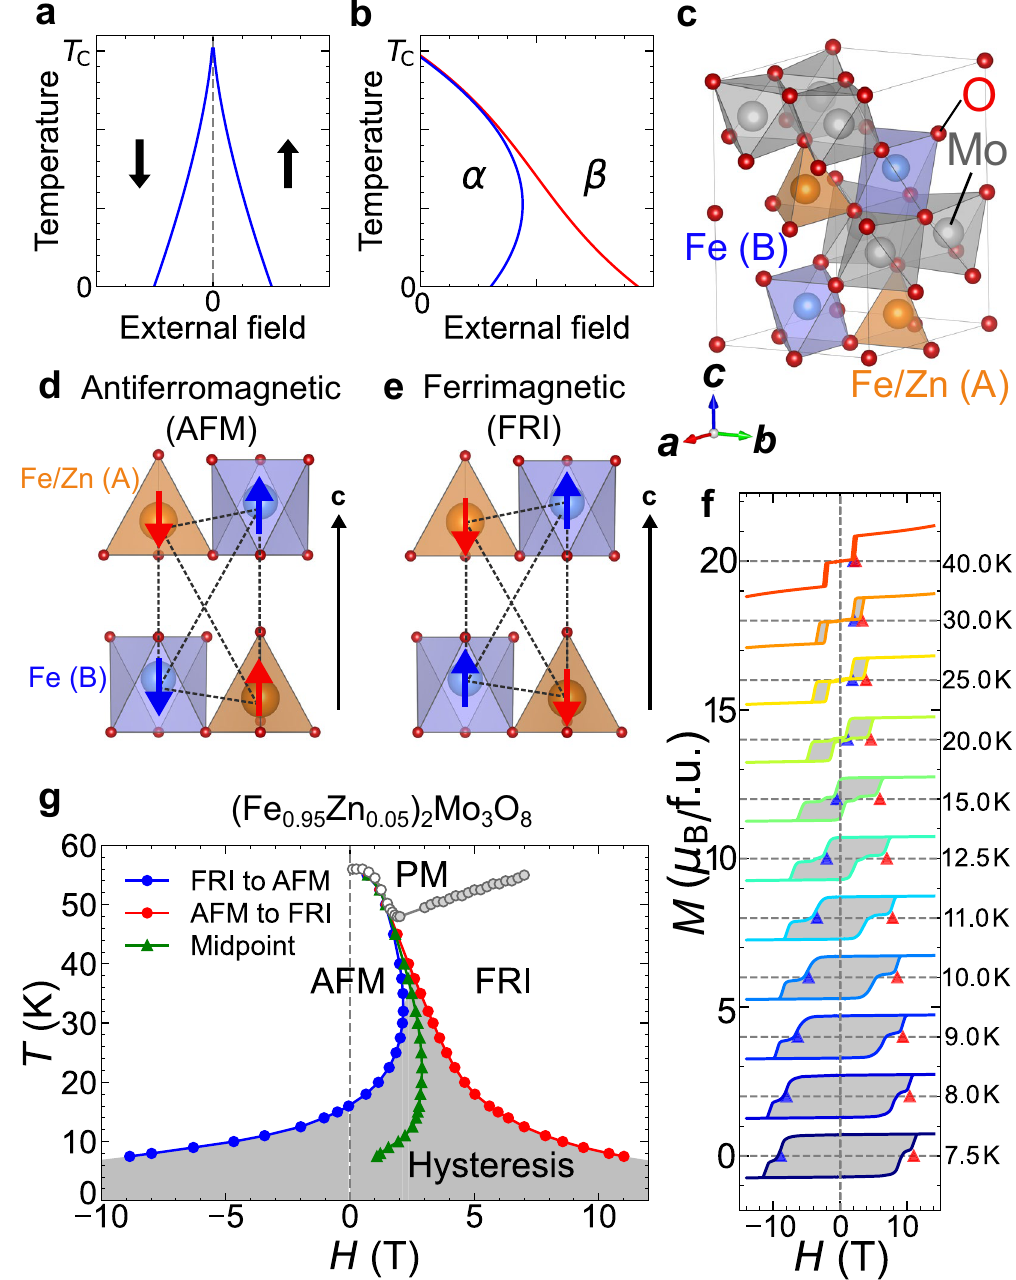
Figure 1. Field-temperature phase diagram of ( Fe 0.95 Zn 0.05 ) 2 Mo 3 O 8 . ( a,b ) Phase diagrams with temperature and external field axes in the system with field-induced first-order phase transitions: ( a ) ferroic-order case in which two states are connected with symmetry operations, such as time-reversal and space-inversion symmetries, and ( b ) two-phase-competing case in which two thermodynamic phases indicated by α and β are not degenerate in free energy at zero external field. The solid lines in ( a ) and ( b ) represent magnetic fields at which the phase transition is observed during magnetic field sweeps 2 + at a given rate. ( c ) The crystal structures of ( Fe 1 − y Zn y ) 2 Mo 3 O 8 . Fe ions at the A-sites (brown) and B-sites (blue) are 4 + surrounded by oxygen tetrahedra and octahedra, respectively. Mo ions (gray) form the nonmagnetic spin-trimer. ( d,e ) The magnetic structure of the ( d ) antiferromagnetic (AFM) and ( e ) ferrimagnetic (FRI) phases. ( f ) The isothermal magnetization curves of ( Fe 0.95 Zn 0.05 ) 2 Mo 3 O 8 at selected temperatures. Each curve is shifted by 2 µ B / f.u. for clarity. The transition from the AFM to the FRI phases and from the FRI to the AFM phases are indicated by red and blue triangles, respectively. ( g ) The temperature-magnetic-field phase diagrams of ( Fe 0.95 Zn 0.05 ) 2 Mo 3 O 8 . The transitions from the AFM to the FRI phases and from the FRI to the AFM phases are indicated by red and blue circles, respectively. Gray closed and open circles represent the transition between PM and AFM and the crossover between PM to FRI, respectively, and they were determined from M − T curves. Green triangles represent the midpoints between two transitions from the AFM (FRI) to the FRI (AFM) phases. In ( g,f ), the gray-hatched areas represents the hysteresis